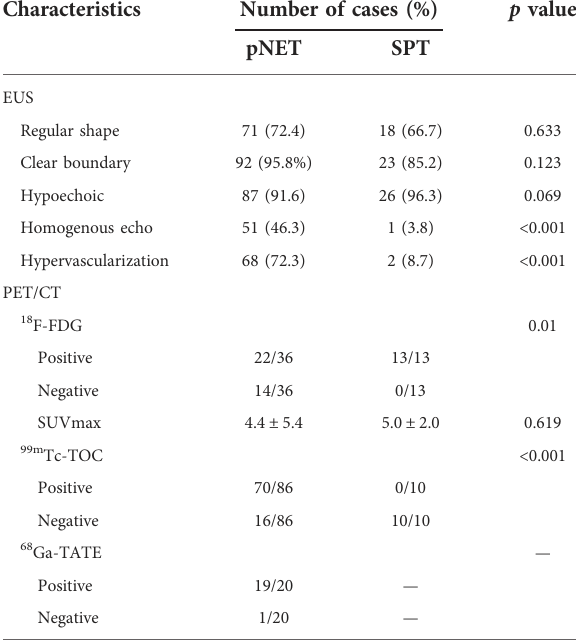
TABLE 4 EUS and PET/CT characteristics of pNET and SPT.